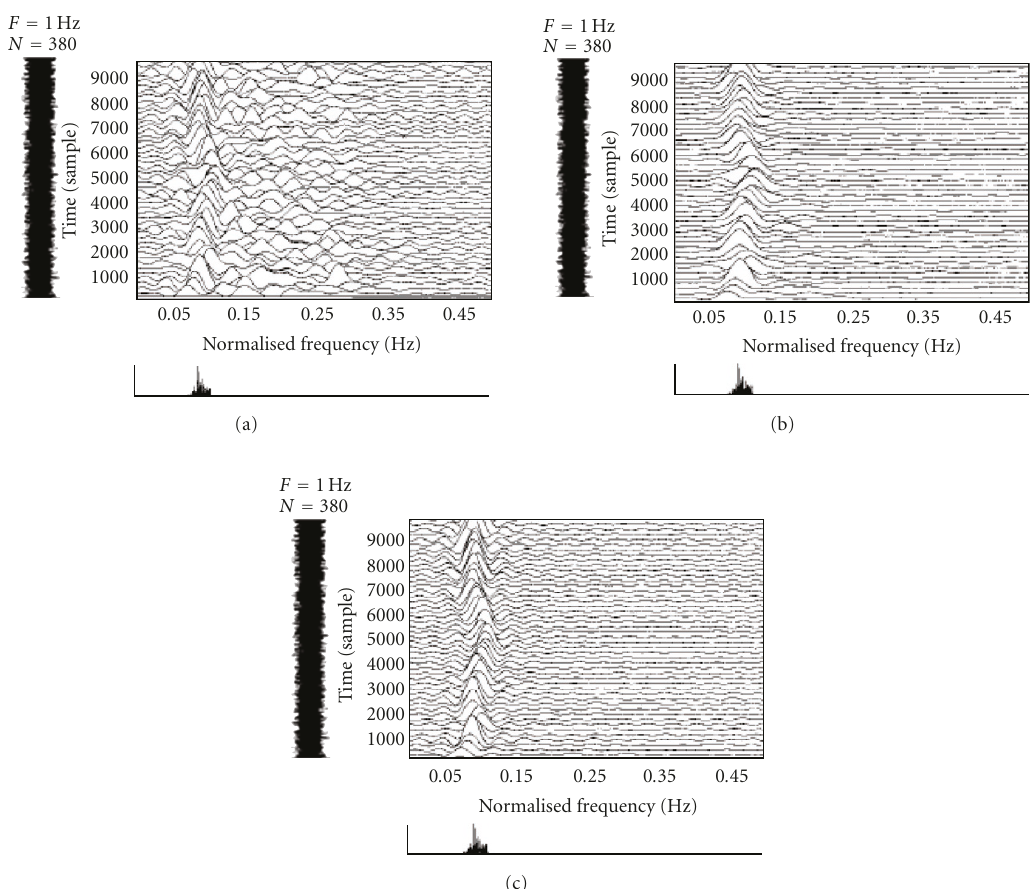
Figure 14: (a) WVD, (b) the spectrogram, and (c) the proposed distribution of a real-life acoustic signal (adopted from Barkat and Boashash [138]).